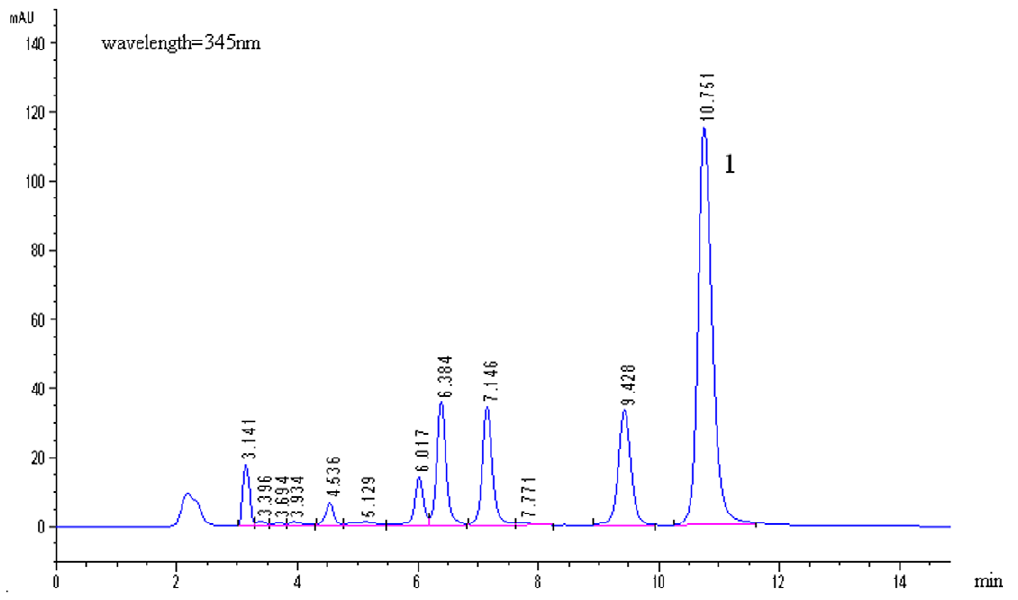
Figure 7. HPLC fingerprint of ethanol extracts of Rhizoma coptidis (RC). Chromatogram conditions: Kromasil C18 column (5 m m, 4.6 mm 6 250 mm), column temperature, 30 u C; mobile phase, acetonitrile: H 2 O (0.05 M KH2PO4, pH 3.0)=30:70 (v/v); elution rate, 1 ml/min; detector wavelength, 345 nm. Peak ‘‘1’’, berberine (content, 24.2%).